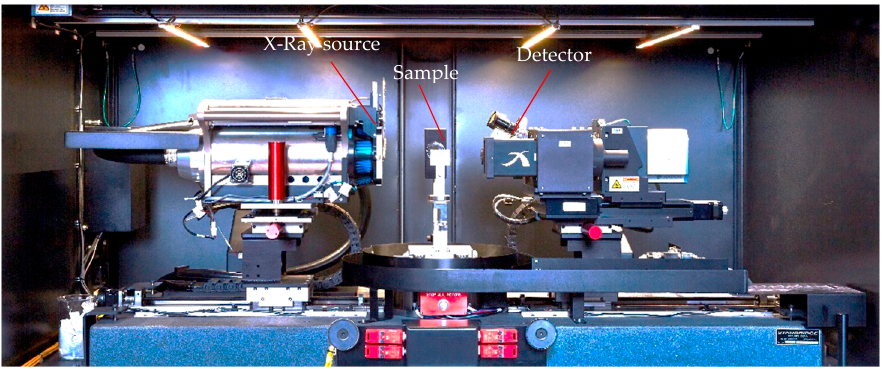
Figure 4. Zeiss xradia 520 Versa used for microcomputed tomography.